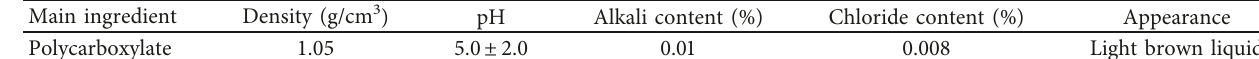
Table 4: Material properties of the superplasticizer.